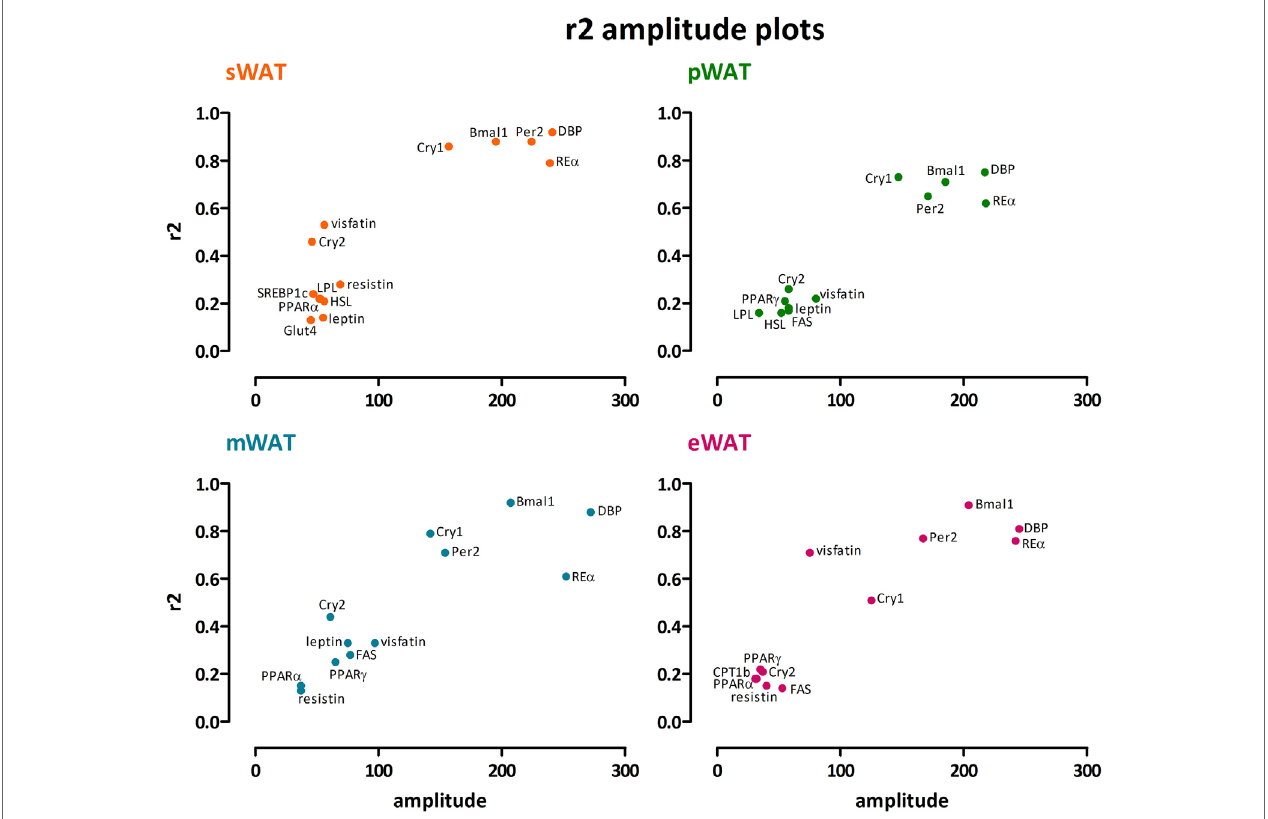
FigUre 3 | Clock genes show high amplitude together with high r 2 , whereas for metabolic genes modest amplitudes go along with low r 2 values. A clear exception is Cry2, which showed much lower amplitude and r 2 values than the other clock genes. We found no distinct differences between subcutaneous and intra- abdominal white adipose tissue (WAT) depots. sWAT, subcutaneous; mWAT, mesenteric; eWAT, epididymal; pWAT, perirenal. Individual expression curves for each gene and WAT depot can be found in Figure S1 in Supplementary